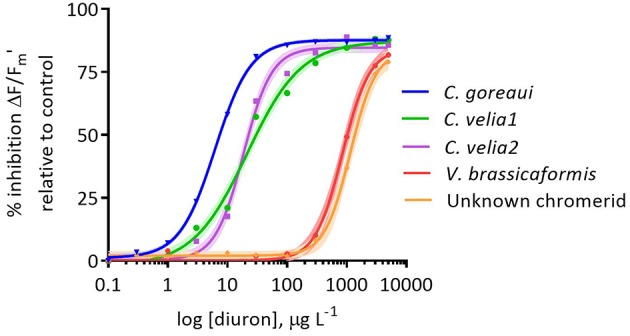
Dose-response of the percentage inhibition of the effective (ΔF/Fm′) quantum yields of Cladocopium goreaui and four chromerid strains exposed for 48 h to diuron at 27°C. Inhibition is relative to the quantum yield values at 0 μg L−1of diuron. Curves are fitted with non-linear regressions. Data points represent means (n = 9). The narrow-shaded areas represent confidence interval (95%) bands.